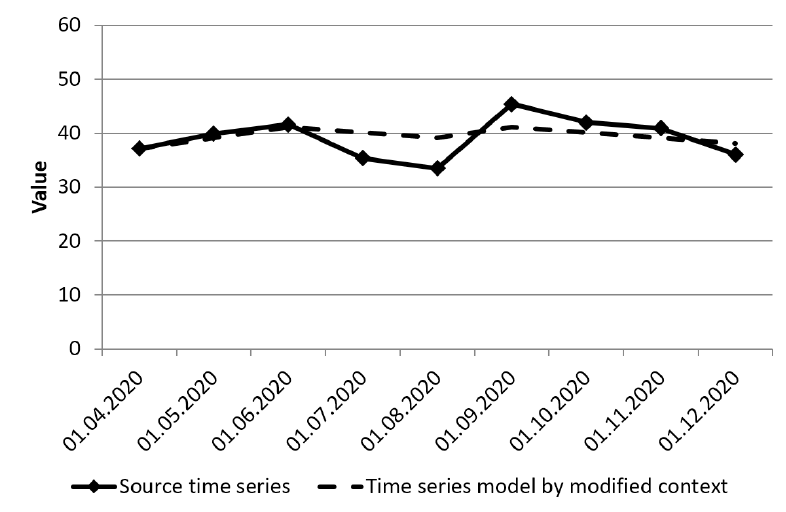
Figure 5. Time series representation based on modified